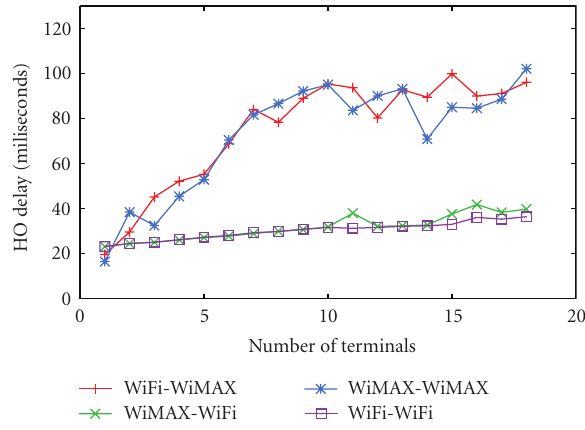
Figure 13: E ff ect of number of terminals on optimized HO